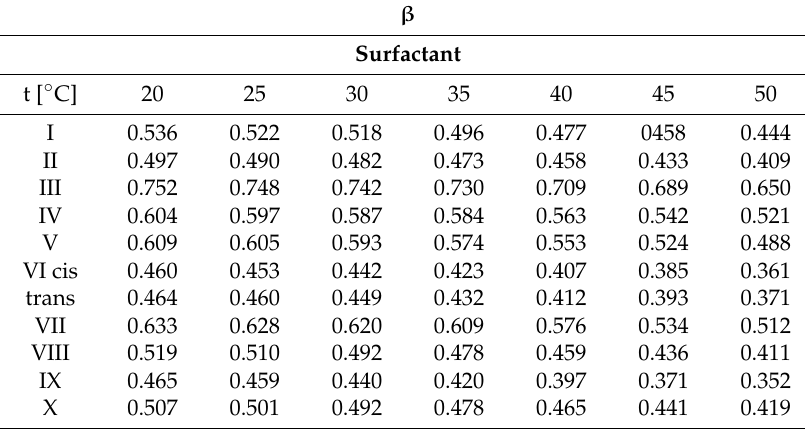
Table 5. Calculated values of degrees of counterion binding for all surfactant solutions at the temperature 20–50 ◦